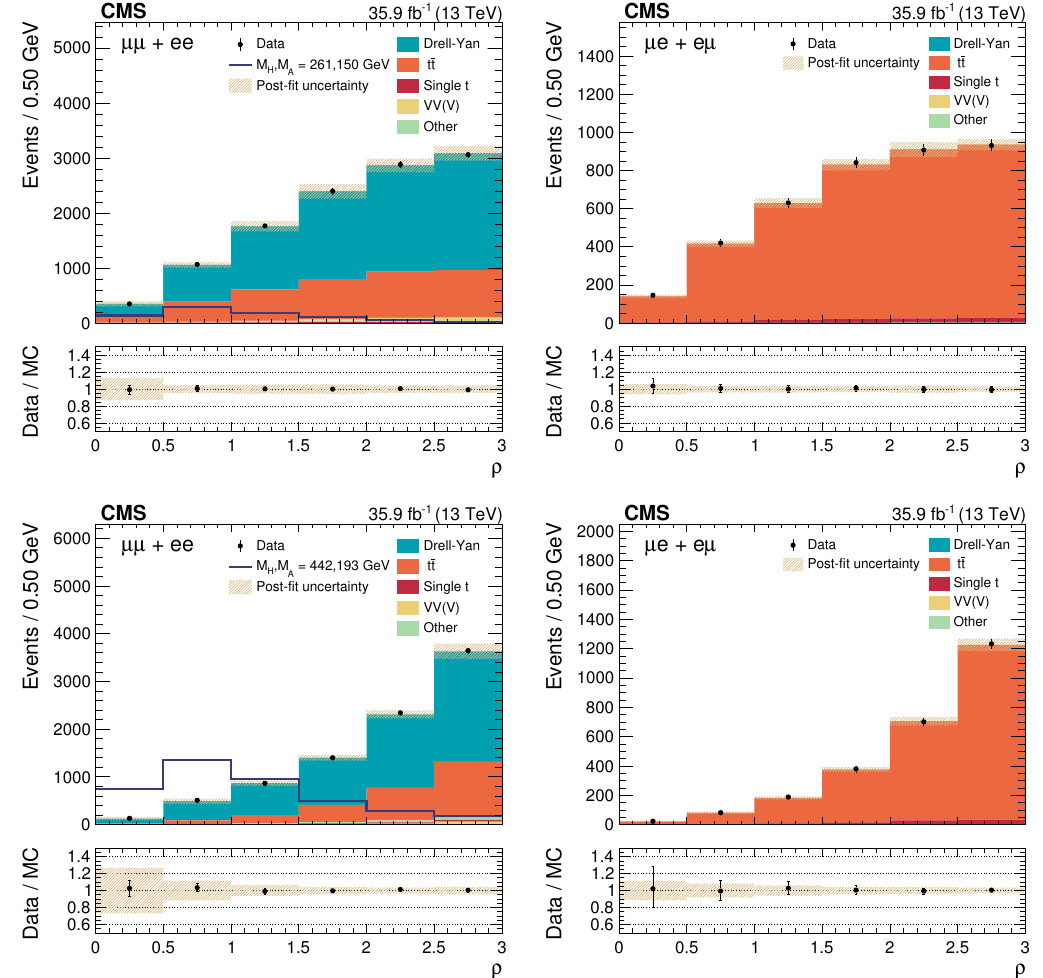
Figure 5 . Post-(cid:12)t (cid:26) distributions from a background-only (cid:12)t for the same-(cid:13)avour lepton (left) and mixed-(cid:13)avour lepton (right) events corresponding to a signal hypothesis with m = 261 GeV and H m = 150 GeV (upper) and m = 442 GeV and m = 193 GeV (lower). The signal is normalised to A H A 1 pb. Error bars indicate statistical uncertainties, while shaded bands show systematic uncertainties after the